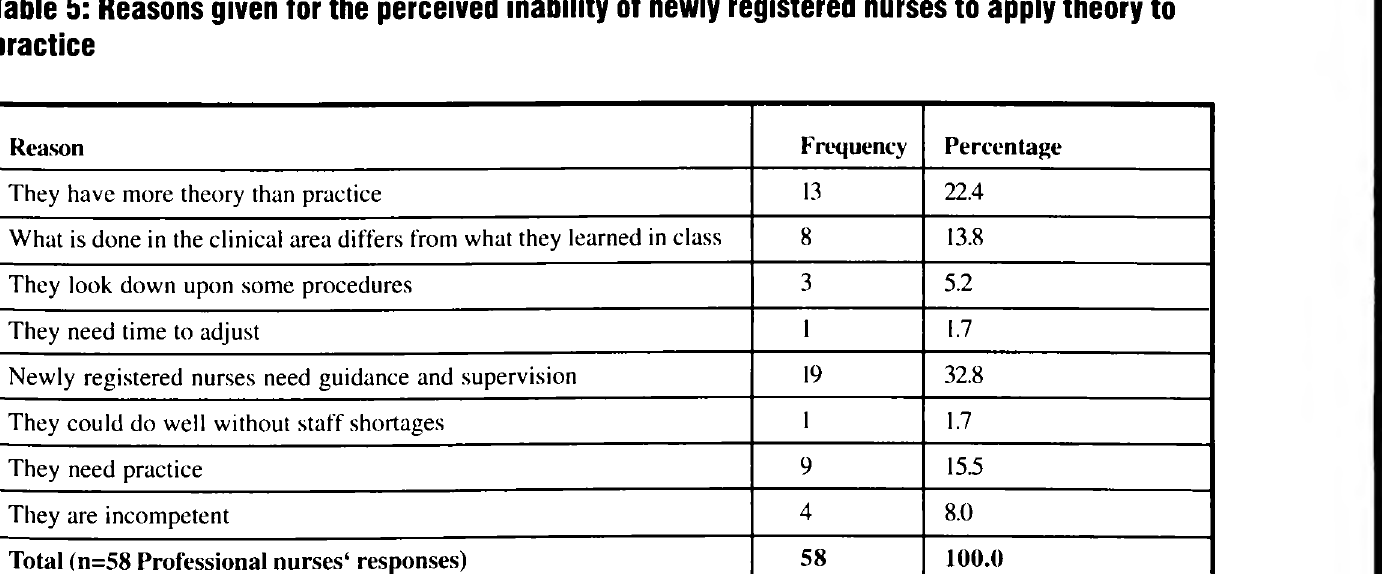
Table 5: Reasons given for the perceived inability of newly registered nurses to apply theory to